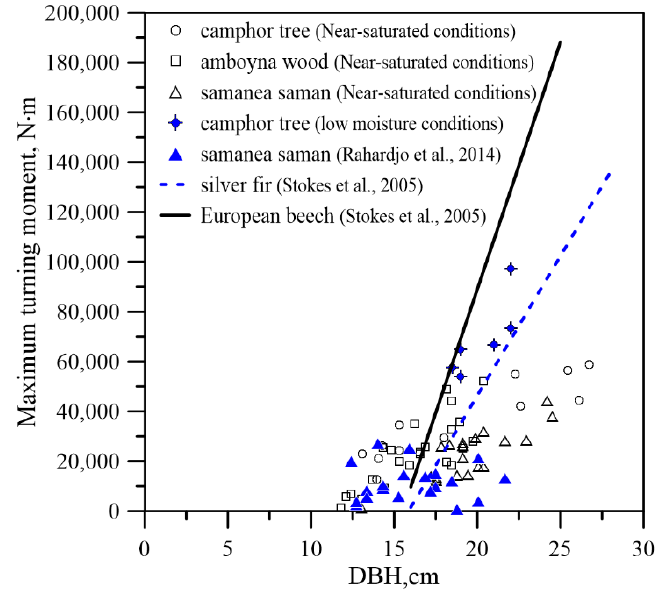
Figure 7. The maximum resisting moment vs. DBH for different trees.